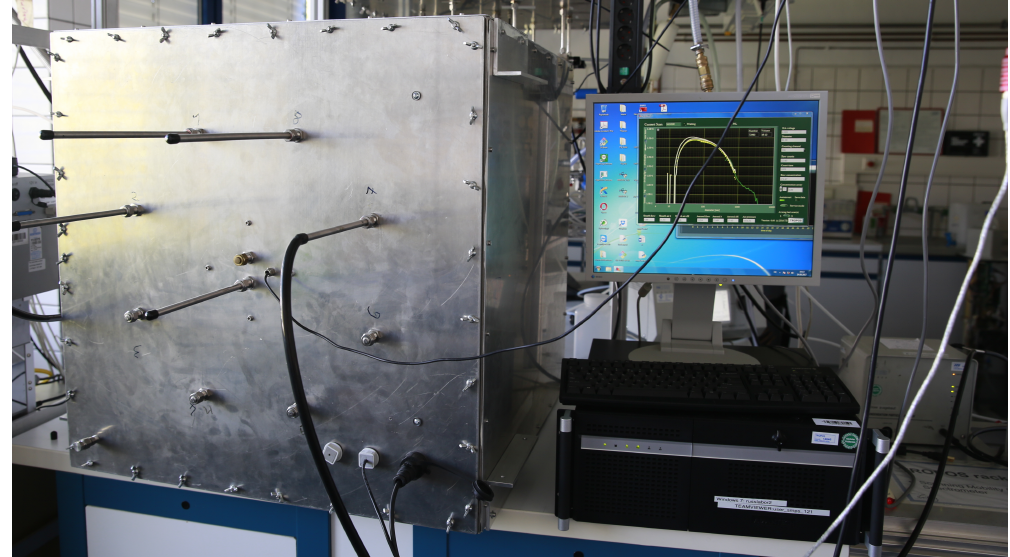
Figure 7. Evaluation Setup: The FeinPhone prototypes were placed inside an aluminum measurement chamber ( left ), into which a varying concentration of polydisperse particles was injected. A custom SMPS and a TSI APS ( right ) were used for reference